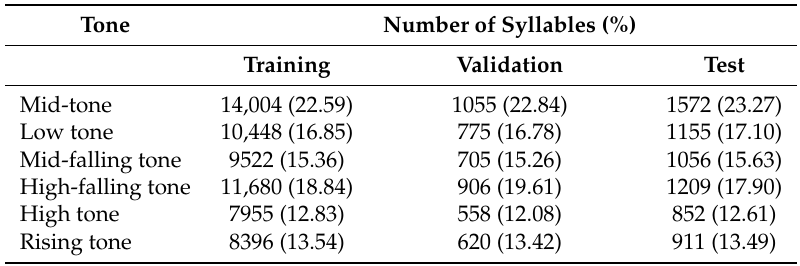
Table 3. Total number of syllables for each tone in training, validation, and test